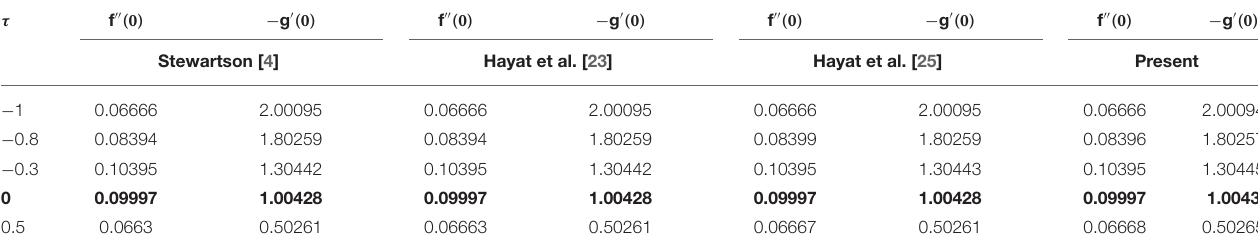
TABLE 2 | Comparison of f ′′ (0) and g ′ (0) with Stewartson [4], Hayat et al. [24], and Hayat et al. [25] when φ = A 1 = A 2 = 0 and Re = 1. τ f ′′